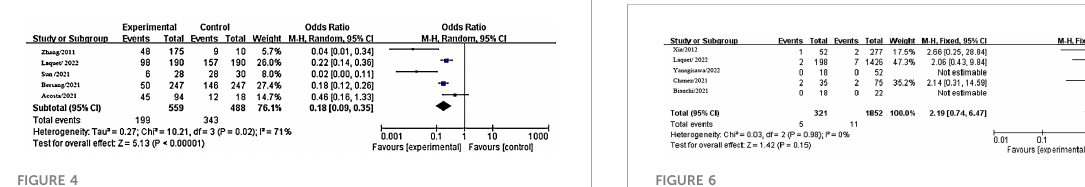
FIGURE 6 Forest plot of 5-year cancer-speci fi c survival in two groups of patients.